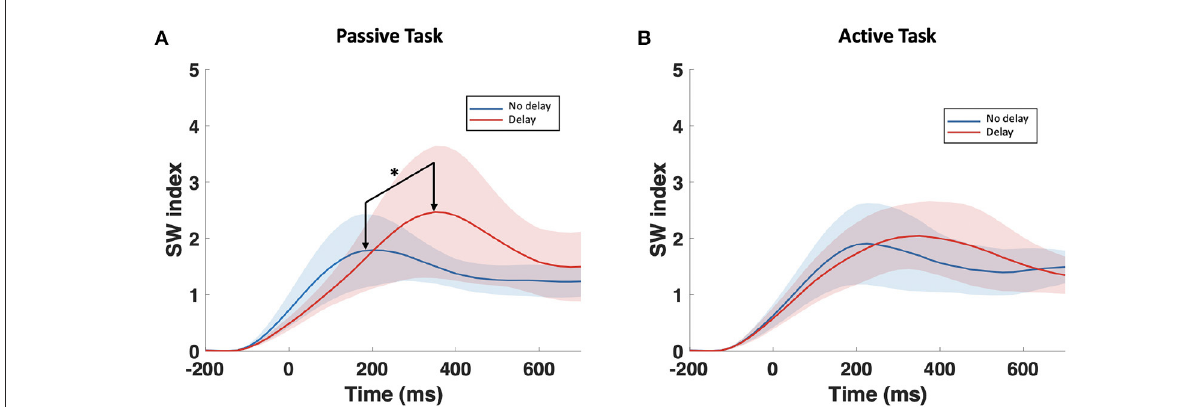
FIGURE4 Time-course of SW norm index in the delta-theta band for the (A) passive task and the (B) active task. The onset (0 ms) is the visual collision event. *Indicates statistically significant